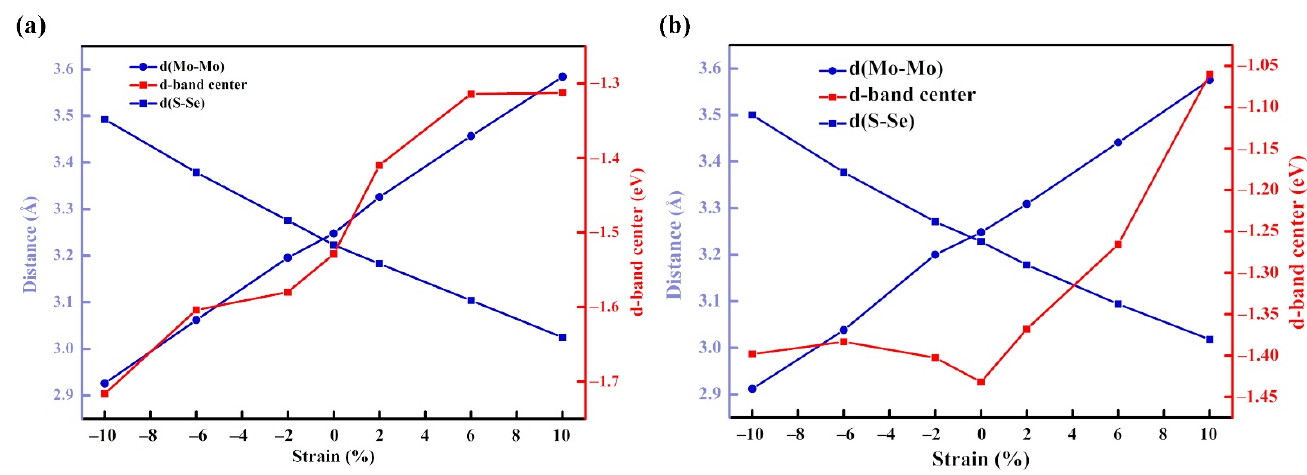
Figure 6. Effect of changing strain on structure and d-band center of ( a ) Ni@MoSSe, ( b )